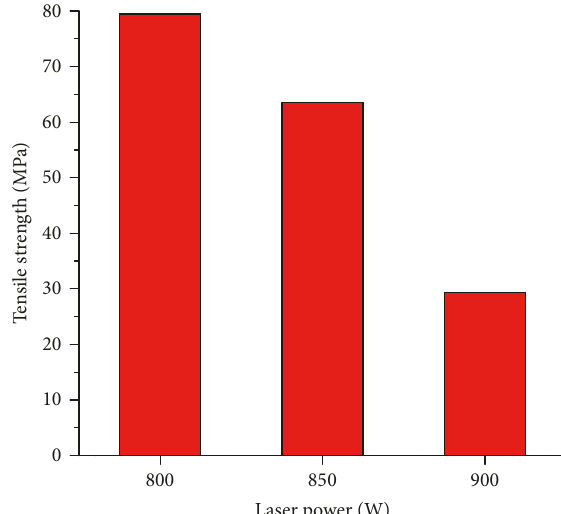
Figure 25: Dependence of tensile strength on laser power (laser beam offset of 250 𝜇